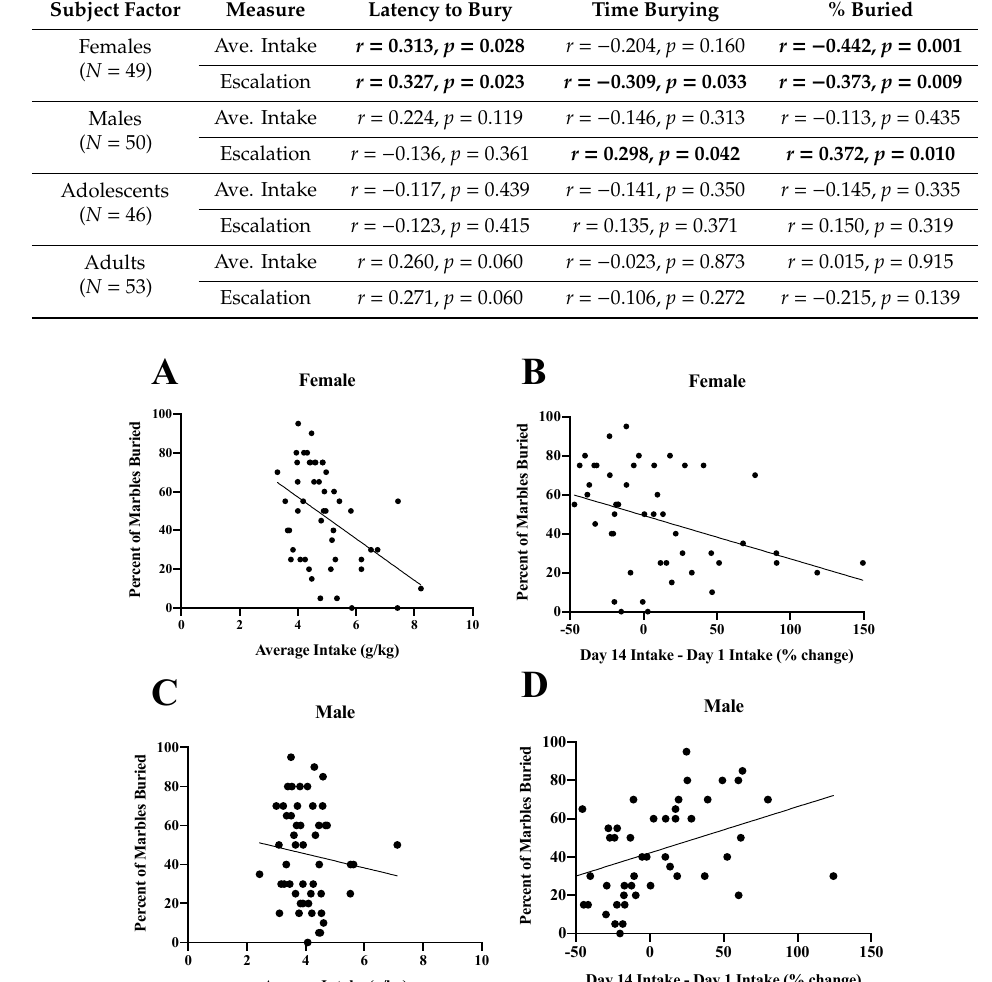
Table 2. Summary of the inter-relations between the average alcohol intake and measures of anxiety-like behavior in the marble-burying test, expressed as a function of our between-subjects factors. the average alcohol intake and basal, as well as stressor-induced increases in, corticosterone (CORT) as a function of the independent variables investigated. The number of mice included in each individual analysis is indicated in parentheses. Significant correlations are indicated in bold. WD = withdrawal day.